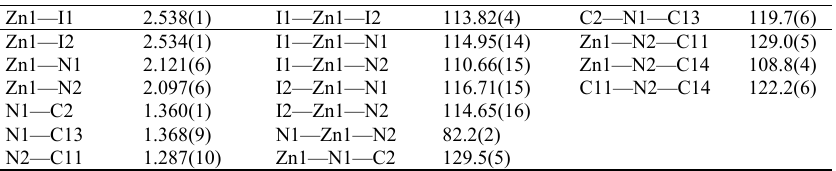
Fig. 3. SEM photographs of compound 1 nanoparticles prepared by (a) sonochemical method, and (b) hydrothermal method Figure .for compound 1) o Selected bond lengths (Å) and angles (Table 3. ٤ Table 3. Selected bond lengths (Å) and angles (o) for compound 1